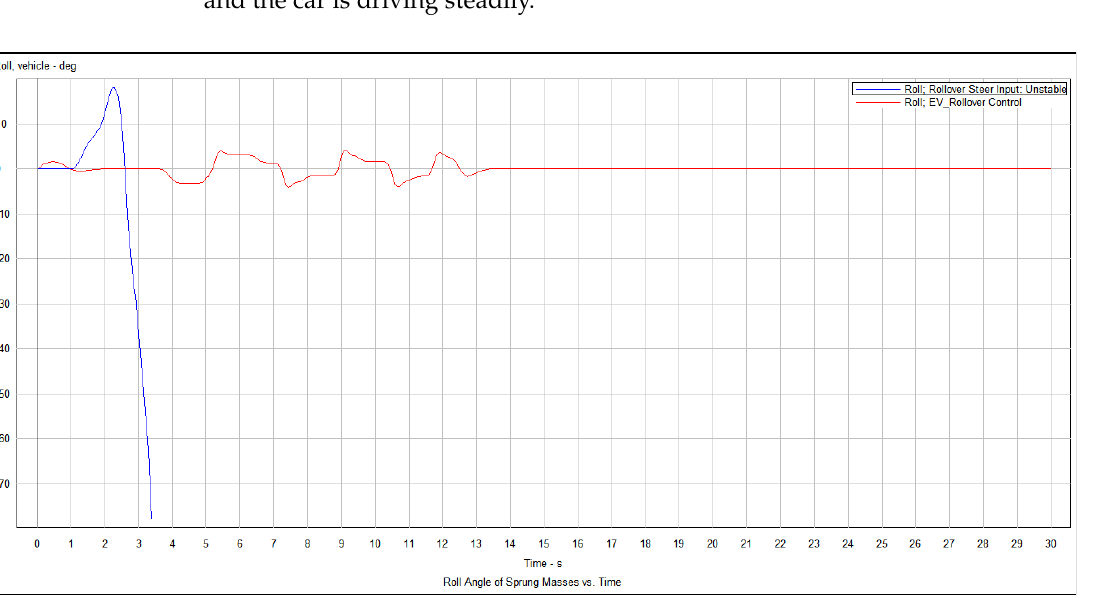
Figure 13. Roll rate comparison curve for double lane-change test.